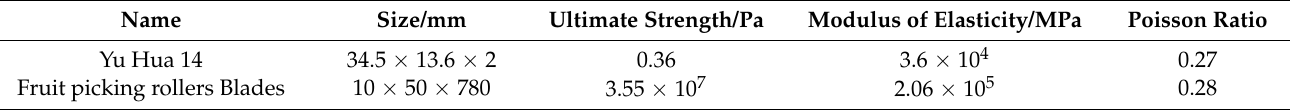
Table 2. Relevant material data.